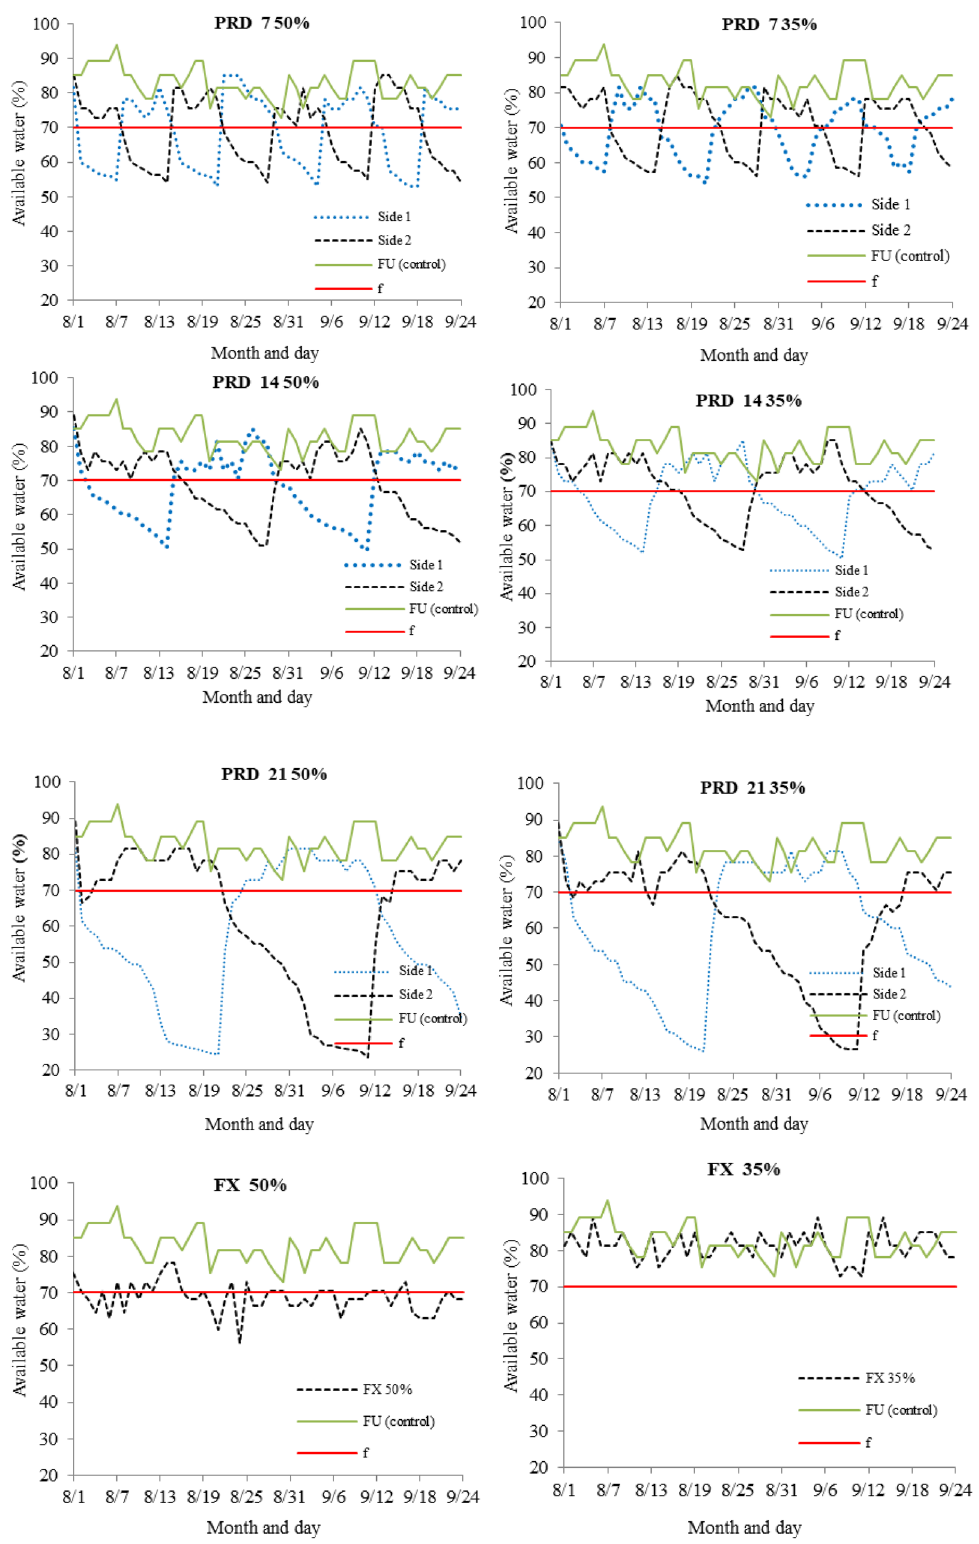
Figure 5. Available water in the soil under the different PRD irrigation regimes: partial rootzone drying, with 50 and 35% reductions in the water irrigation depth (WID), alternating at 7, 14 and 21 days; FX: fixed irrigation on one side of the rootzone, with 50 and 35% reductions in WID; FU: full irrigation, 100% of WID, and f: lower limit of soil water availability for papaya, in Bom Jesus da